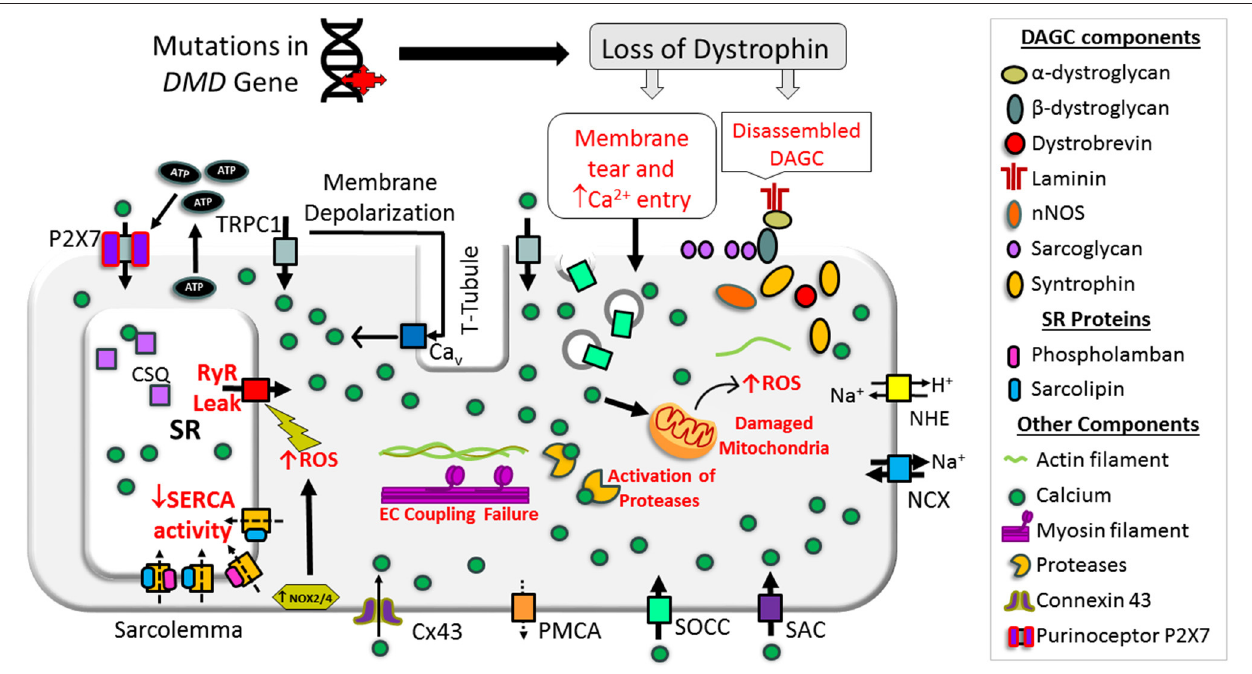
FIGURE 2 | Schematic representation of mechanisms causing Ca 2 + i overload in a dystrophin-deficient muscle cell. Loss of dystrophin causes destabilization of dystrophin-associated glycoprotein complex (DAGC), membrane tear, and activation of store-operated calcium channels (SOCCs), resulting in abnormal Ca 2 + entry. High concentrations of extracellular ATP can activate abnormal Ca 2 + influx via P2X7. RyR dysfunction causes Ca 2 + leak from the SR and SERCA dysfunction compromises Ca 2 + resequestration. NOX activation can also increase RyR Ca 2 + leak. These changes result in abnormal and chronic elevation of the cytoplasmic Ca 2 + levels. Supraphysiological level Ca 2 + activates Ca 2 + -dependent proteases and phospholipase and causes muscle necrosis and replacement of muscle by fatty and fibrotic tissues. Sustained elevation of cytoplasmic Ca 2 + levels also affects mitochondrial function and increases reactive oxygen species (ROS). Collectively, these changes lead to muscle wasting and contractile dysfunction. Bold and broken arrows indicate the enhanced and decreased function of the Ca 2 + channels, respectively. Cx43, connexin 43; NCX, sodium–calcium exchanger; NHE, sodium–proton exchanger; NOX, NADPH oxidases; PMCA, plasma membrane Ca 2 + ATPase; P2X7, P2X purinoceptor 7; SAC, stretch-activated channels; SOCC, store-operated Ca 2 + channel; TRPC1, transient receptor potential channel